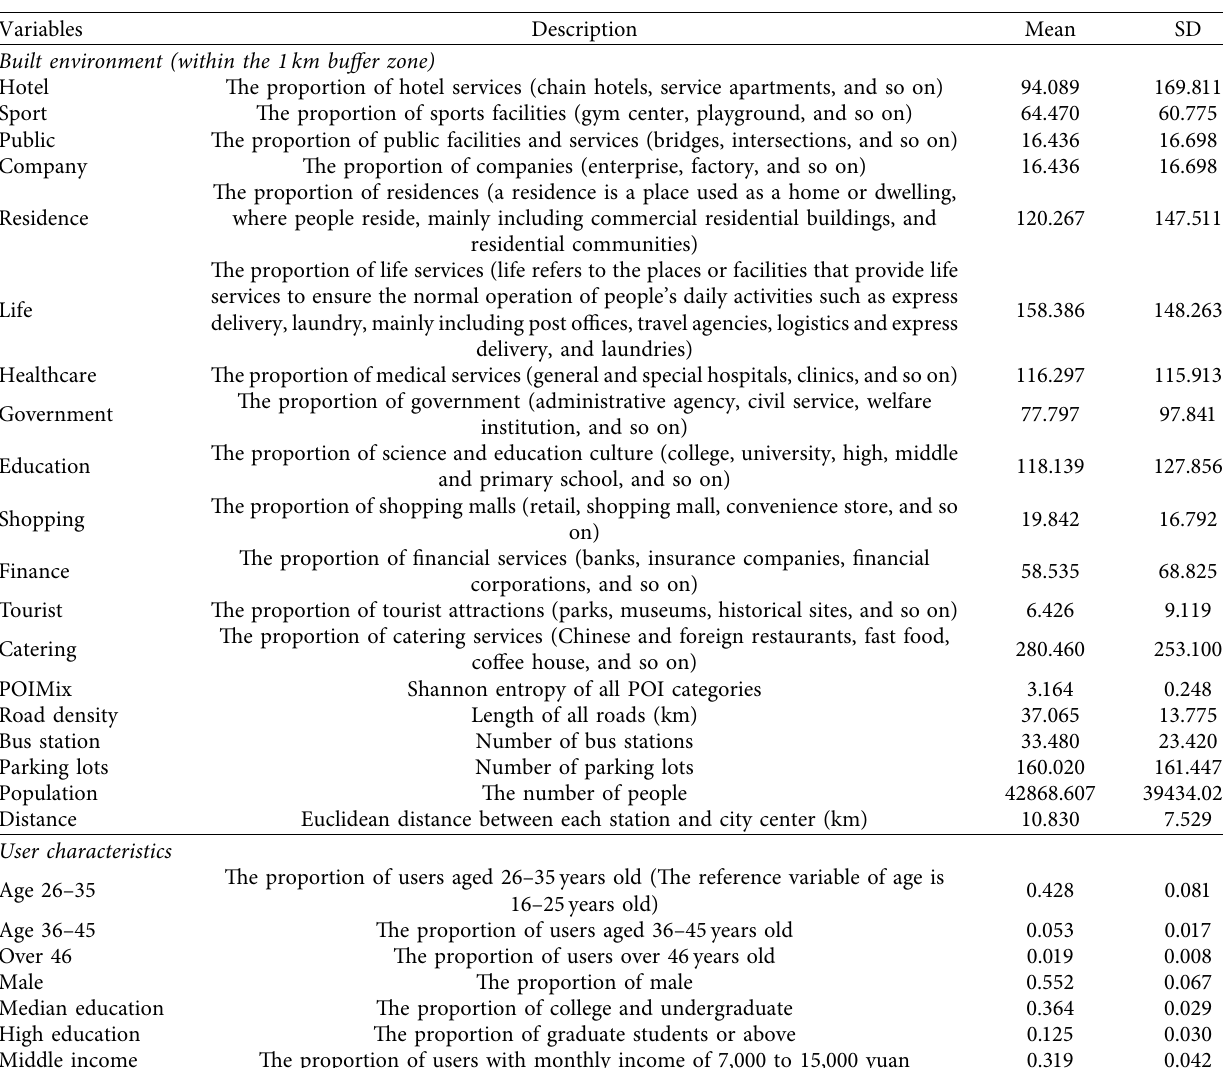
Table 3: Description and statistics of